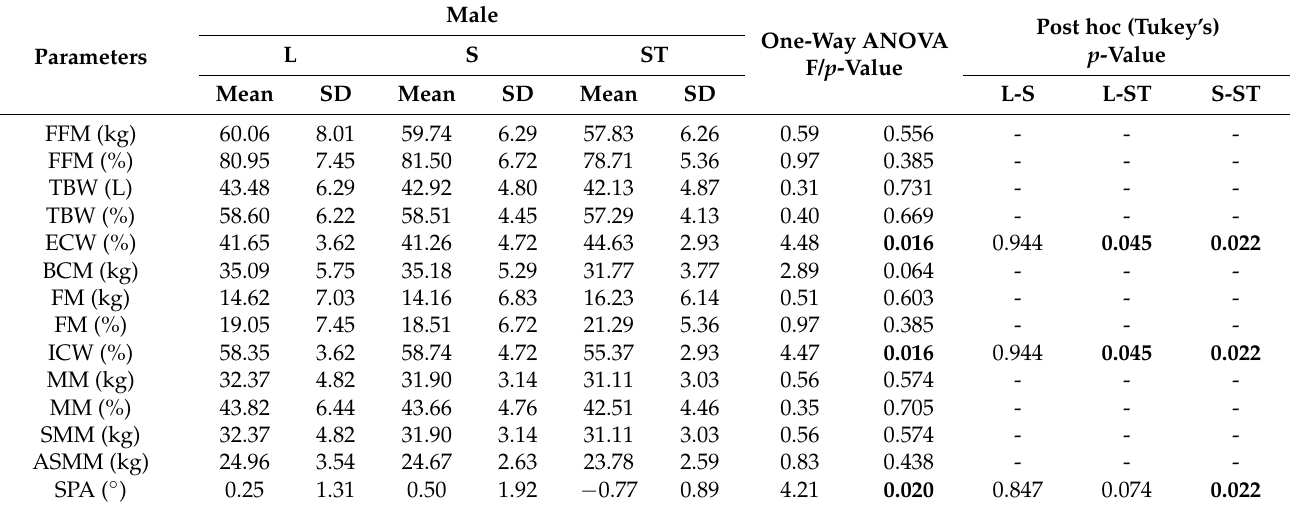
Table 3. Selected components of body composition among